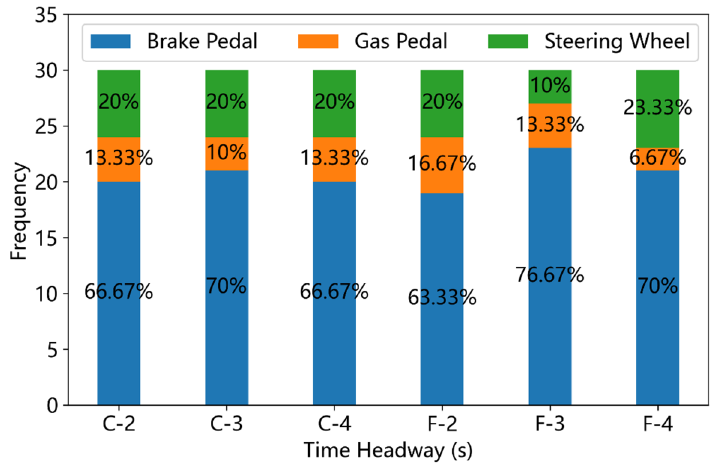
Figure 9. Frequency of different takeover responses under most-critical (ALV = − 4 m/s 2 ) driving scenarios (C means ‘clear weather’ and F denotes ‘fog condition’).